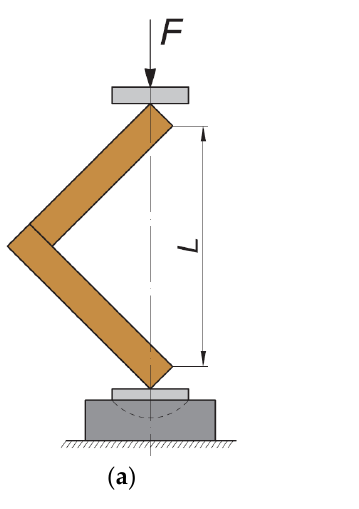
Figure 6. Test procedure. Reprinted with permission from Ref. [11]. 2021 BISMAR. ( a ) Type of loading of the tested samples; ( b ) determination of the bending arm.